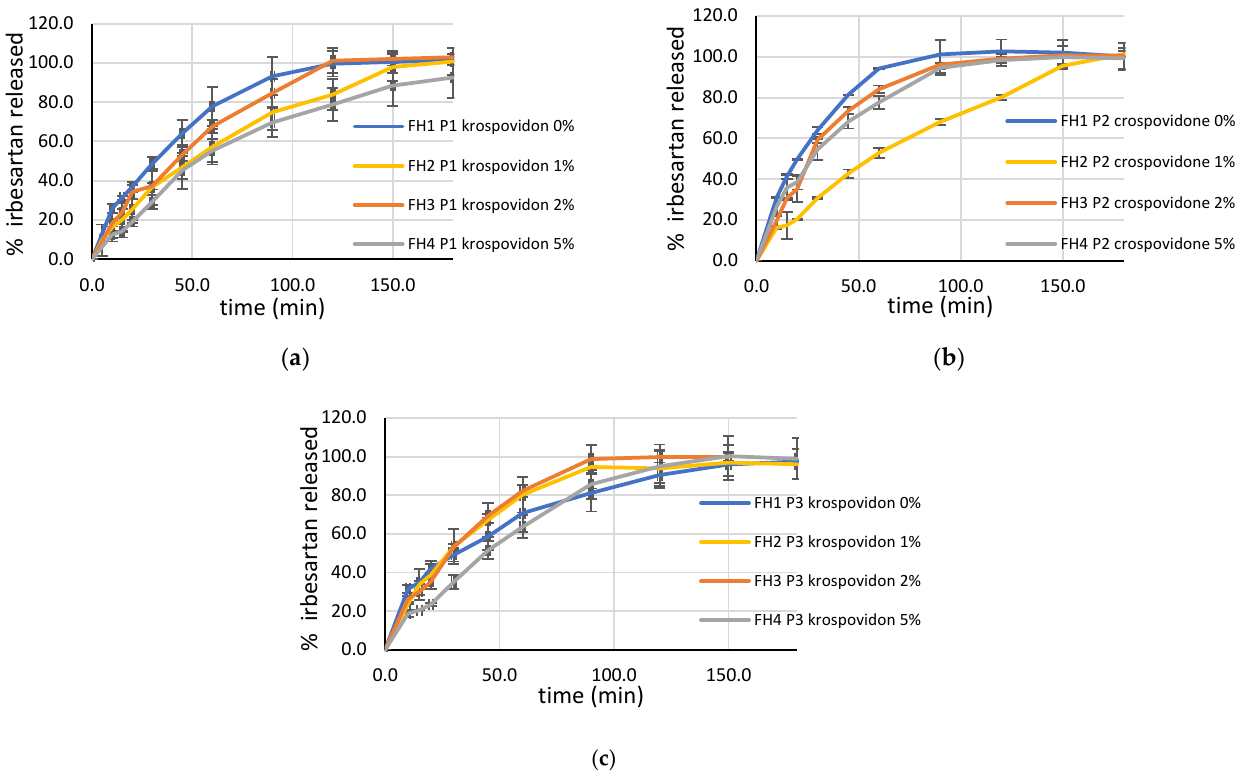
Figure 10. Effect of crospovidone on drug release: ( a ) tablets printed with a laser speed of 100.00 mm/s; ( b ) tablets printed with laser speed of 120.00 mm/s; ( c ) tablets printed with laser speed of 140.00 mm/s.